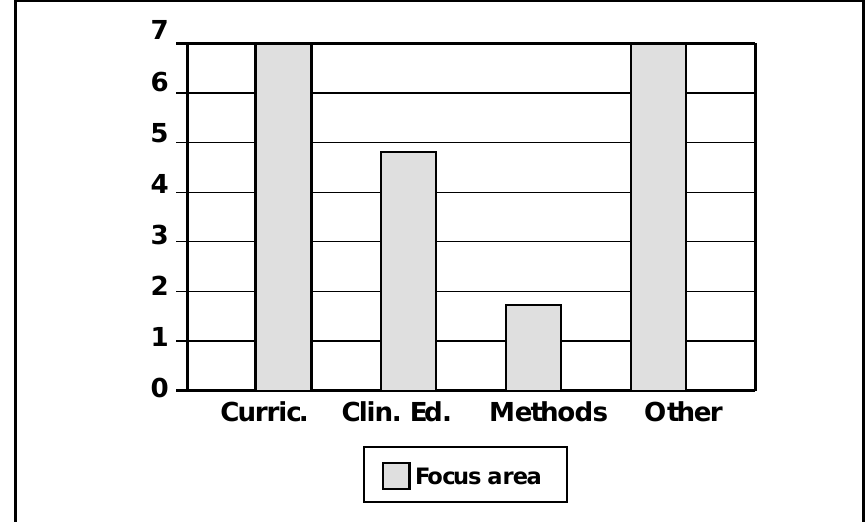
Figure 2: Pedagogic topics/focus areas